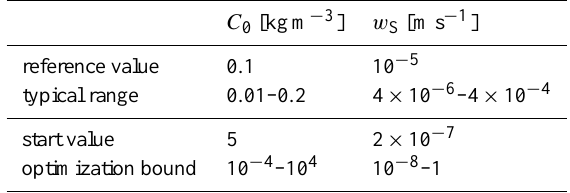
Table 2. Values for the C 2